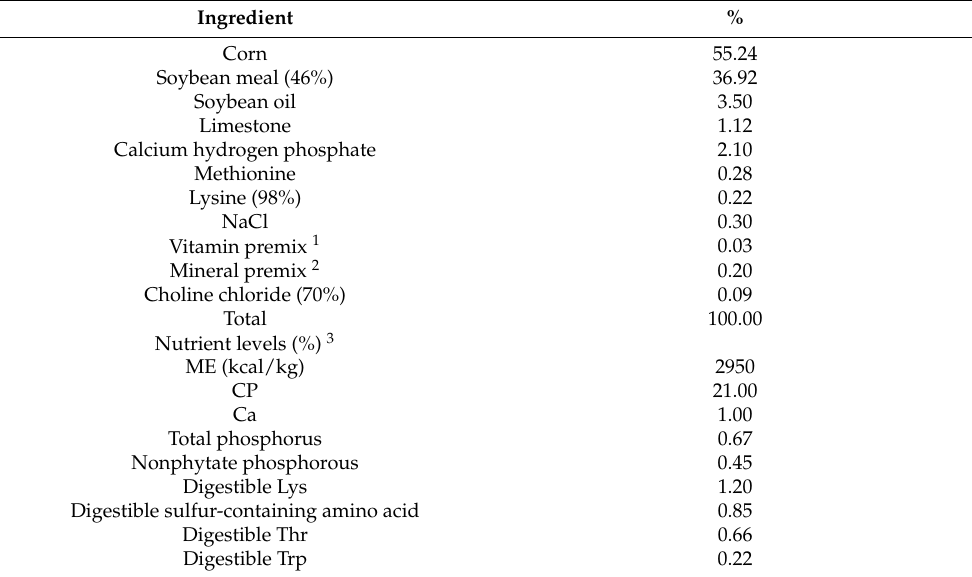
Table 1. Diet composition and nutrient levels (as-fed basis) from 1 to 9 d of